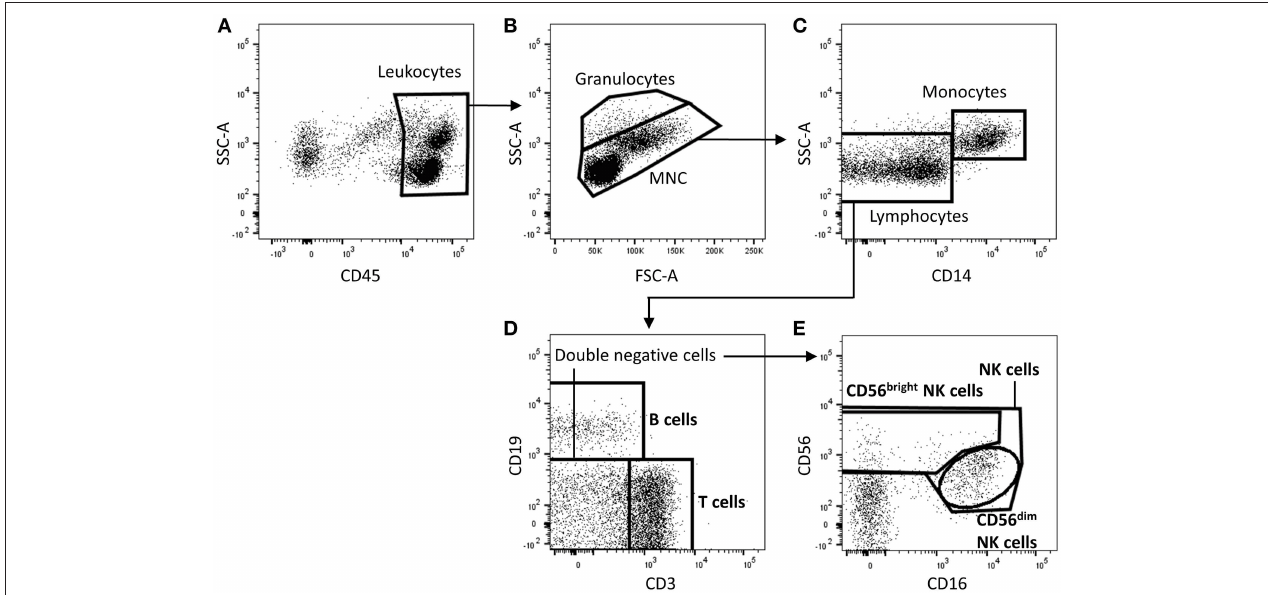
FIGURE 1 | Identification of T cells, B cells, and natural killer (NK) cell subsets in human kidney tissue. Gating strategy used to identify T cells (CD3 + ), B cells (CD19 + ), total NK cells (CD3 − CD19 − CD56 + lymphocytes), and NK cell subpopulations (CD56 dim and CD56 bright NK cells) in human kidney transplant tissue. Single, live, CD45 + mononuclear cells (MNC) and granulocytes are gated on a forward-scatter (FSC)/side-scatter (SSC) plot (A,B) . Total lymphocytes are distinguished from granulocytes and monocytes based on low SSC and absent CD14 expression (C) . Total lymphocytes are further separated into T cells or B cells by their expression of CD3 and CD19 respectively (D) . NK subpopulations, CD56 bright and CD56 dim NK cells, are identified based on CD56 intensity and CD16 expression (E) . Representative flow cytometric data from 1 of 10 individual antibody-mediated rejection (AMR) renal biopsy specimens are shown. An identical gating strategy was used for no rejection, borderline rejection and T cell-mediated rejection (TCMR) biopsies. MNC, mononuclear cells; FSC-A, forward-scatter area; SSC-A, side-scatter